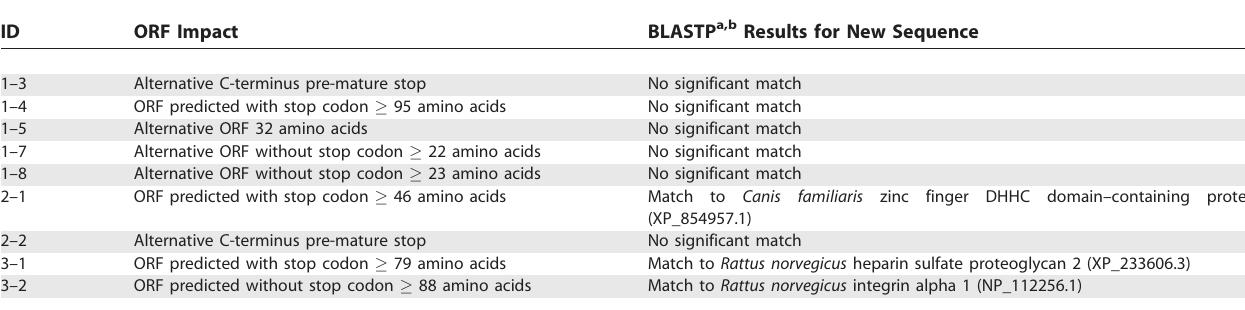
Table 4. ORF and BLASTP Analyses of the RT-PCR and Sequencing Validated Candidates